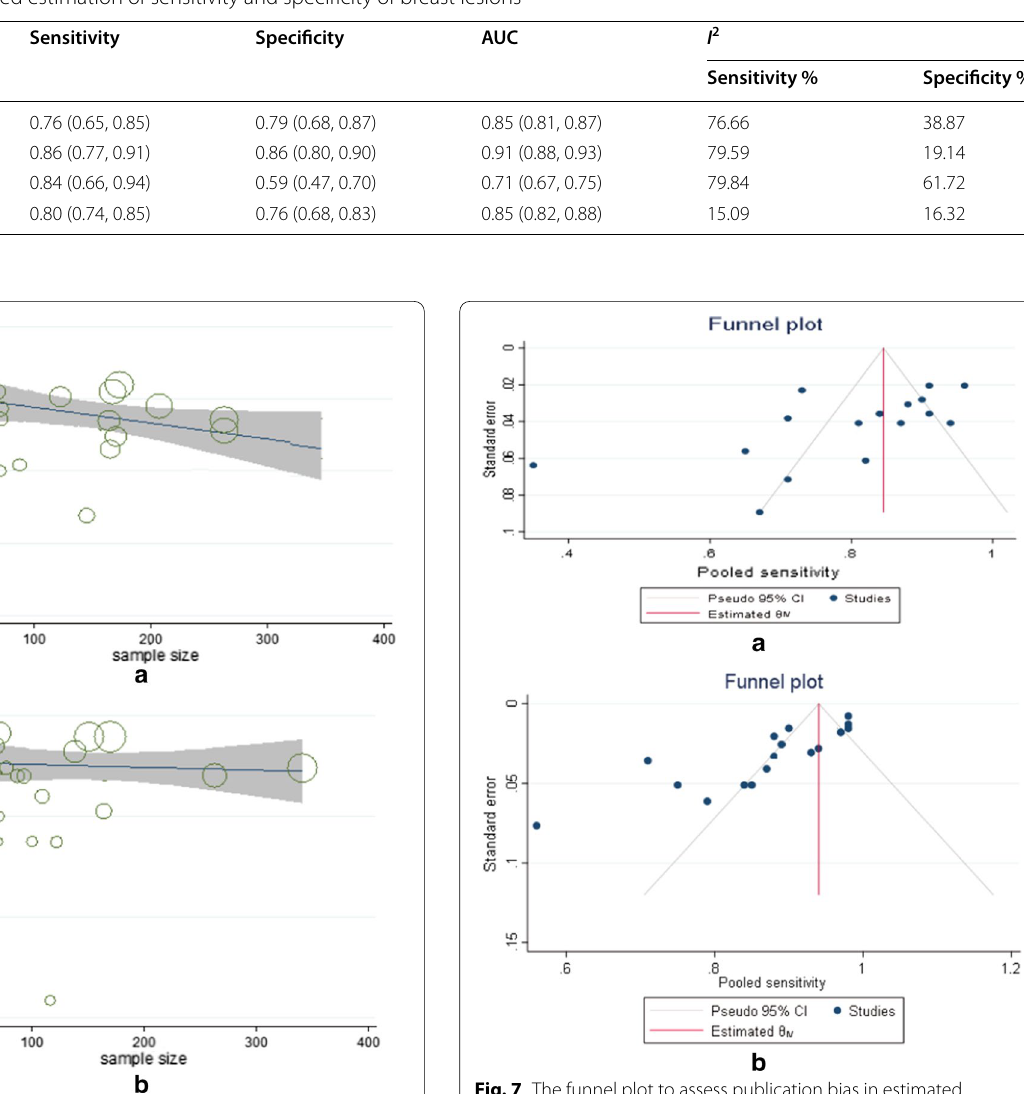
Fig. 6 The distribution of estimated sensitivity ( a ) and specificity ( b ) according to different sample sizes